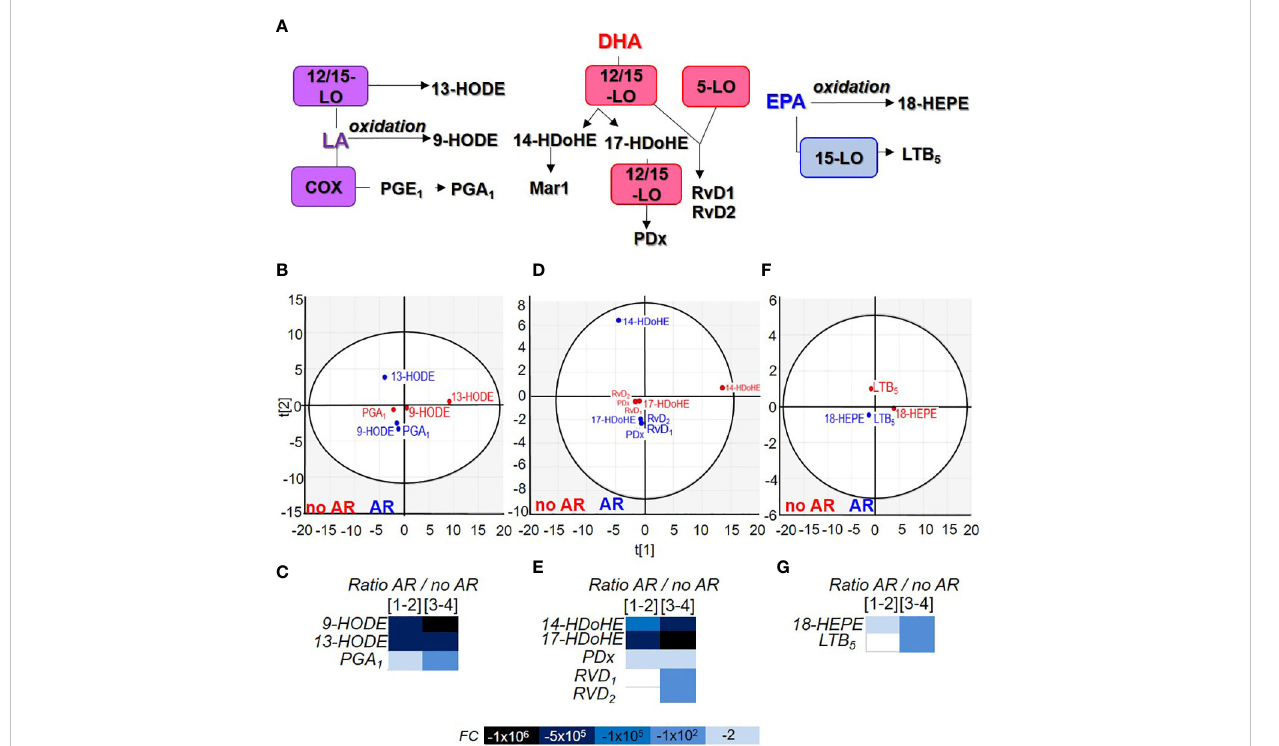
FIGURE 5 Comparison of linoleic acid, docosahexaenoic acid and eicosapentaenoic acid metabolite contained in Single Donor Apharesis during storage and in the event of adverse reactions. (A) Flowchart illustrating the generation of eicosanoids from linoleic acid (LA), docosahexaenoic acid (DHA) and eicosapentaenoic acid (EPA). (B, D, F) Two-dimensional score plot of a principal component analysis of LA products (B) , DHA products (D) and EPA products (F) in SDA-PC without occurrence of AR (red) and with occurrence of AR (blue), taking all storage times into account. (C, E, G) Heat map represents fold change in mean lipid derived from LA (C) , DHA (E) and EPA (G) between SDA-PC with occurrence of AR and from SDA-PC without occurrence of AR for different storage times reported on the heat map. Leukotriene B 5 (LTB 5 ), resolvin D 1 (RvD 1 ), resolvin D 2 (RvD 2 ), protectin Dx (PDx), 9-hydroxyoctadecadienoic acid (9-HODE), 13-hydroxyoctadecadienoic acid (13-HODE), 14-hydroxydocosahexaenoic acid (14-HDoHE), 17- hydroxydocosahexaenoic acid (17-HDoHE), 18-hydroxyeicosapentaenoic acid